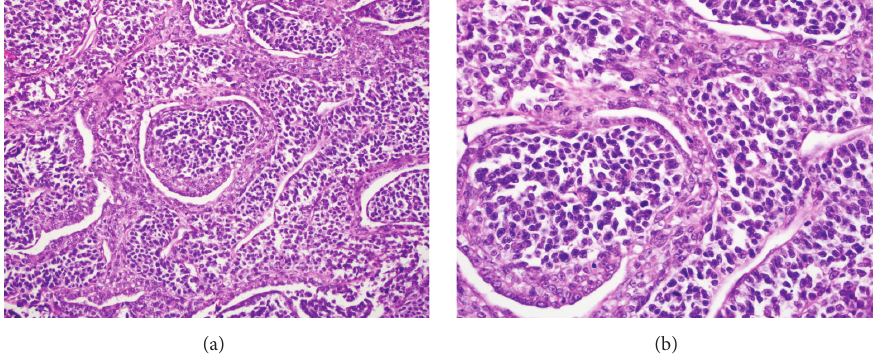
Figure 2: (a) Biphasic tumor with papillary fronds lined by large atypical mesothelial cells, × 200. (b) Neoplastic mesothelial cells with moderate amount of cytoplasm and large nuclei showing partial chromatic clearing and distinct nucleoli, × 600.